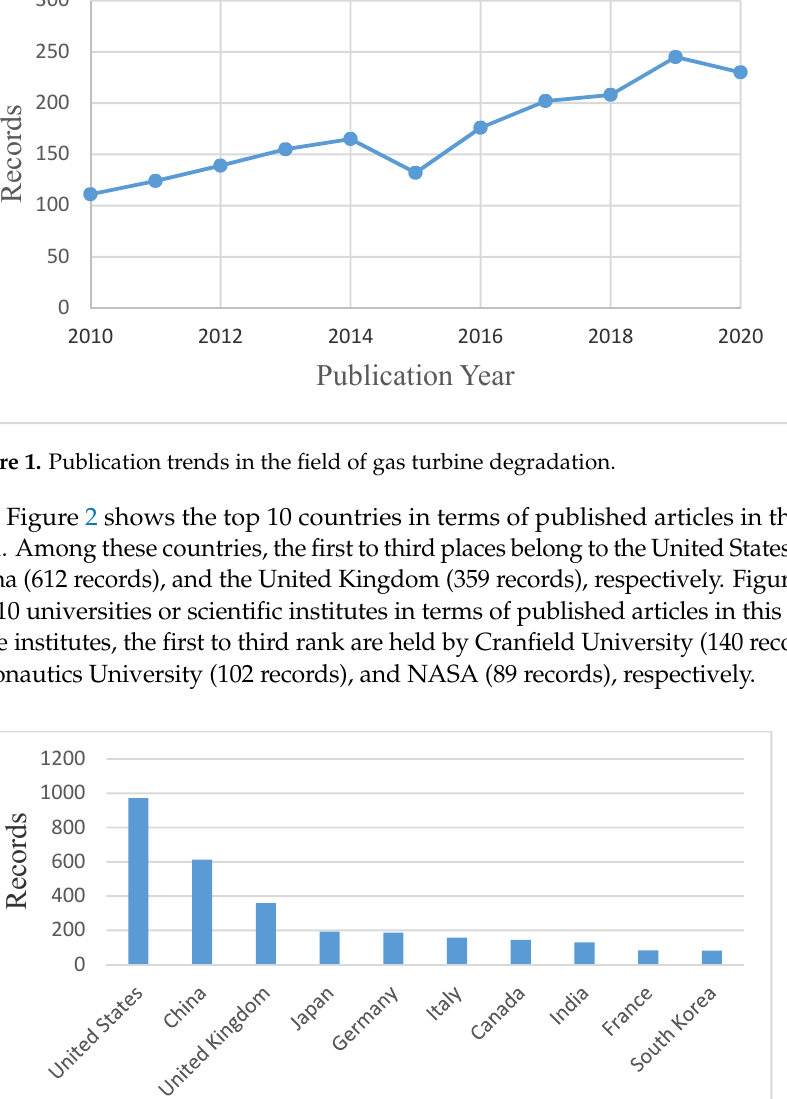
Figure 2. List of top 10 countries in terms of published articles.